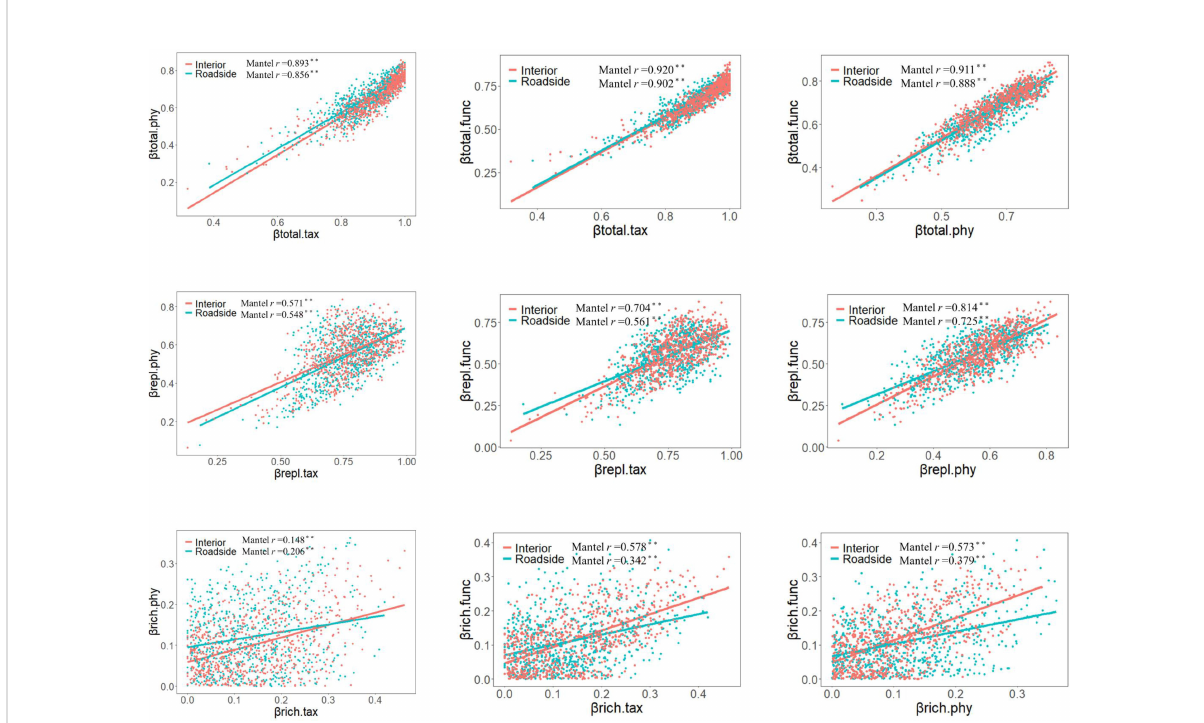
FIGURE 4 Correlations between taxonomic, phylogenetic, and functional total beta diversity ( b total.tax, b total.phy and b total.func), replacement ( b repl.tax, b repl.phy and b repl.func), and richness differences ( b rich.tax, b rich.phy and b rich.func) (n=703). A Mantel test was applied to assess the signi fi cance of the relationship of the Pearson correlation coef fi cient (r): **